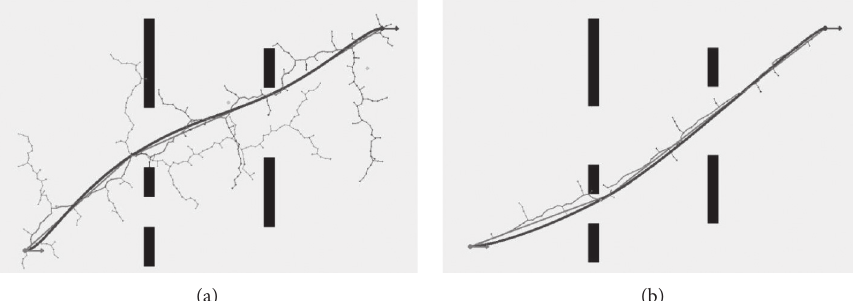
Figure 12: The basic and improved Bi-RRT algorithm in simple environment. (a) The basic Bi-RRT method. (b) The improved Bi-RRT method.